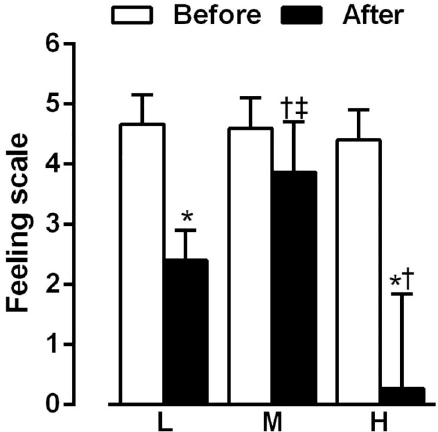
Figure 4 - Values are expressed as mean ± standard deviation of the feeling scale before and after carrying out the protocols of low (L), mo- derate (M), and high (H) cadences. † p < 0.01 vs. L. ‡ p < 0.01